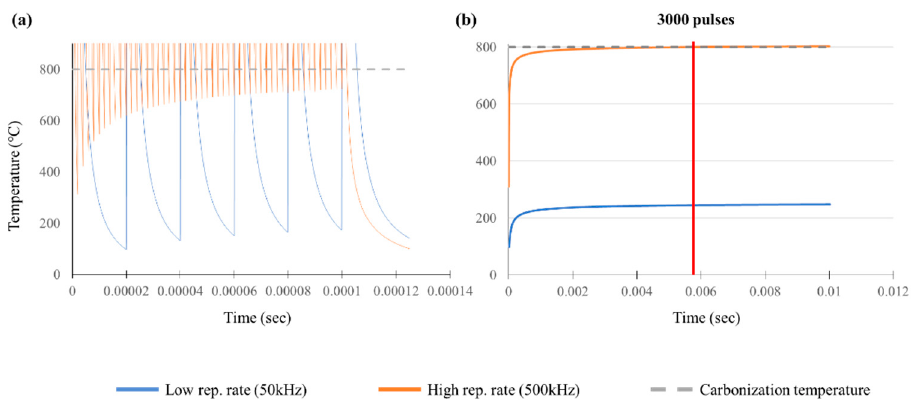
Figure 11. Results of baseline temperature increase due to heat accumulation in PI ( a ) over a few times and ( b ) over more times.